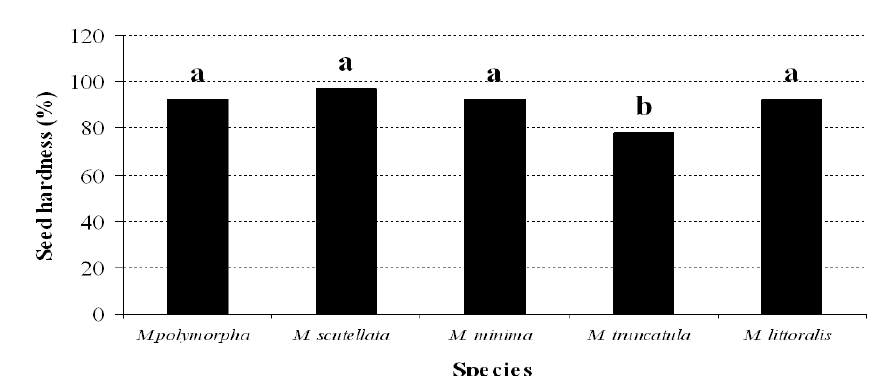
Fig. 13. Main effects of species on harvest index. All the values followed by the same letter in each column are not statistically different at the p<0.05 probability level